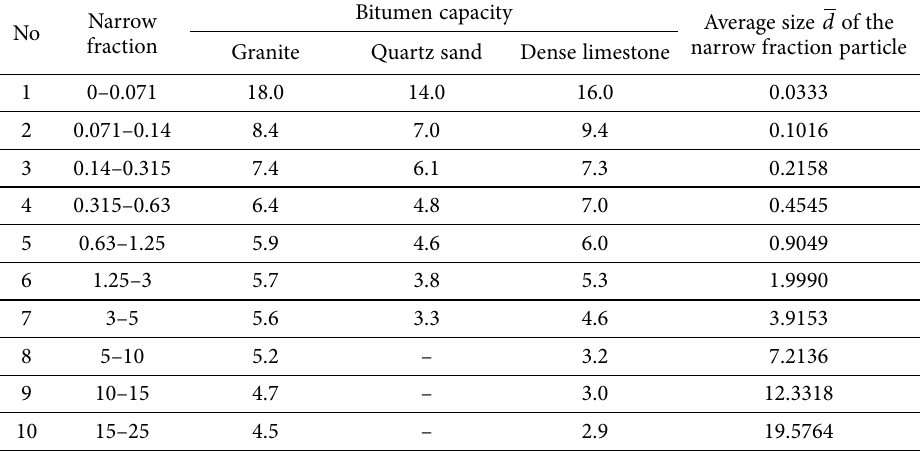
Table 2. Grain sizes of narrow fractions and capacities of the bitumen of different rocks obtained ap- plying standard laboratory sieves of the old-type set and using oil bitumen BND 90/130 Bitumen capacity Average size d of the Narrow No fraction narrow fraction particle Granite Quartz sand Dense limestone